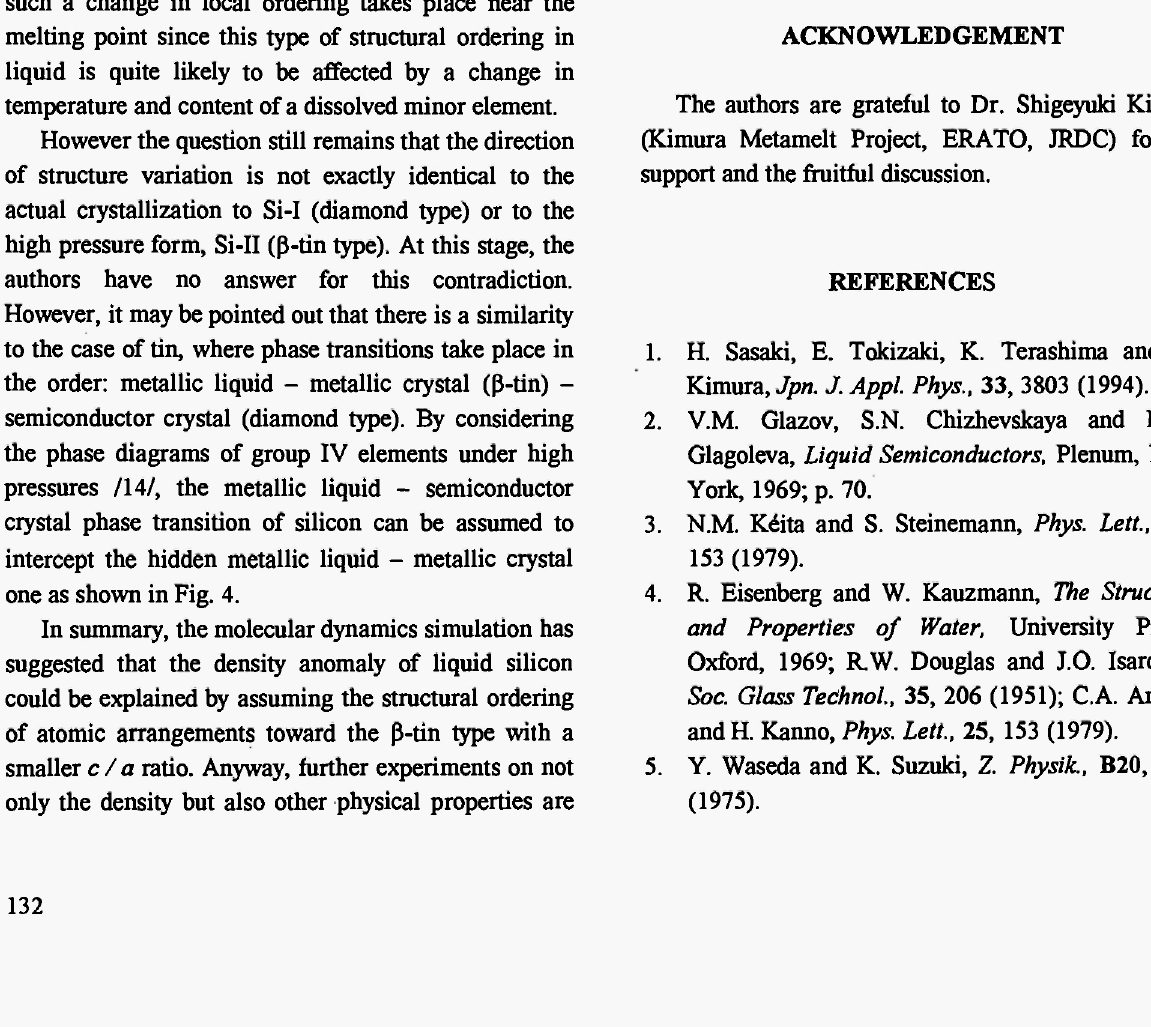
Fig. 4: Schematic phase diagram of the group IV elements under high pressures /14/. Two vertical lines denote the zero-pressure positions for silicon and